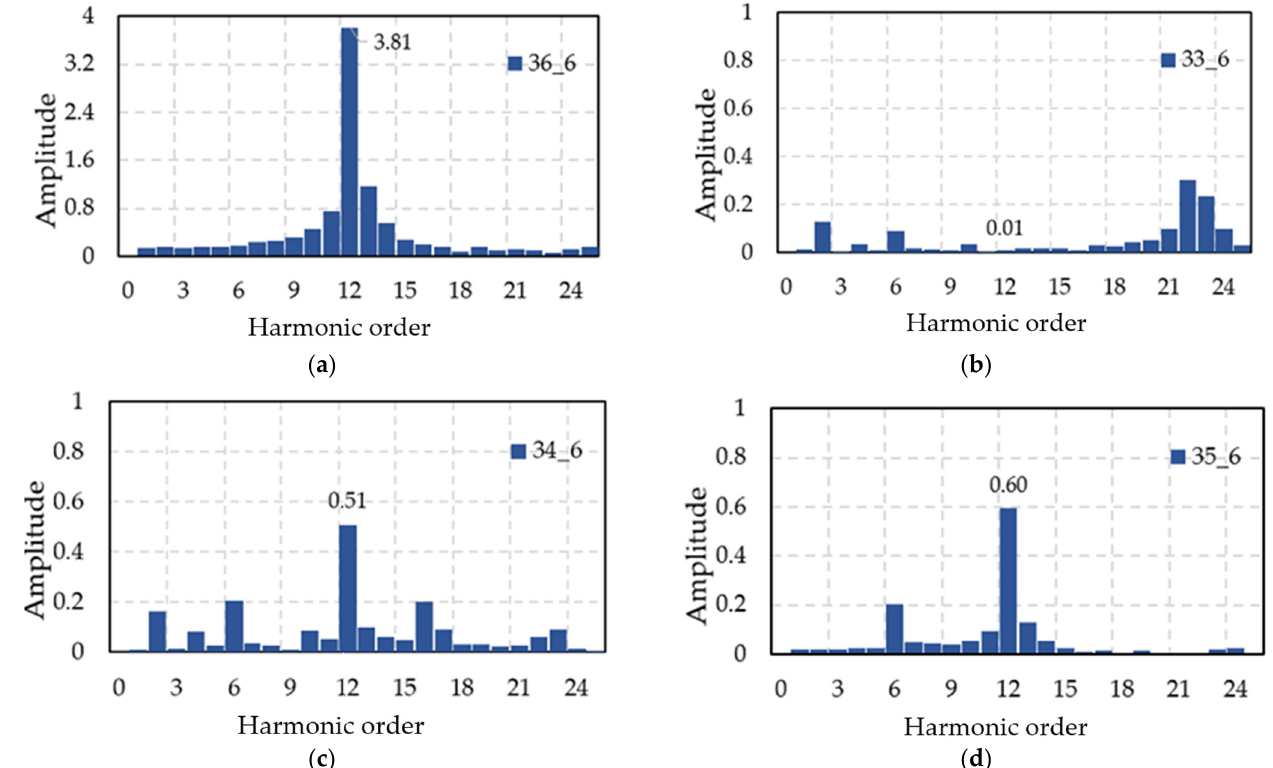
Figure 10. Torque harmonics of four motors with two − layer flux barrier and PM: ( a ) M 1 : 36 − slot and 6 − pole; ( b ) M 2 : 33 − slot and 6 − pole; ( c ) M 3 : 34 − slot and 6 − pole; ( d ) M 4 : 35 − slot and 6 − pole.